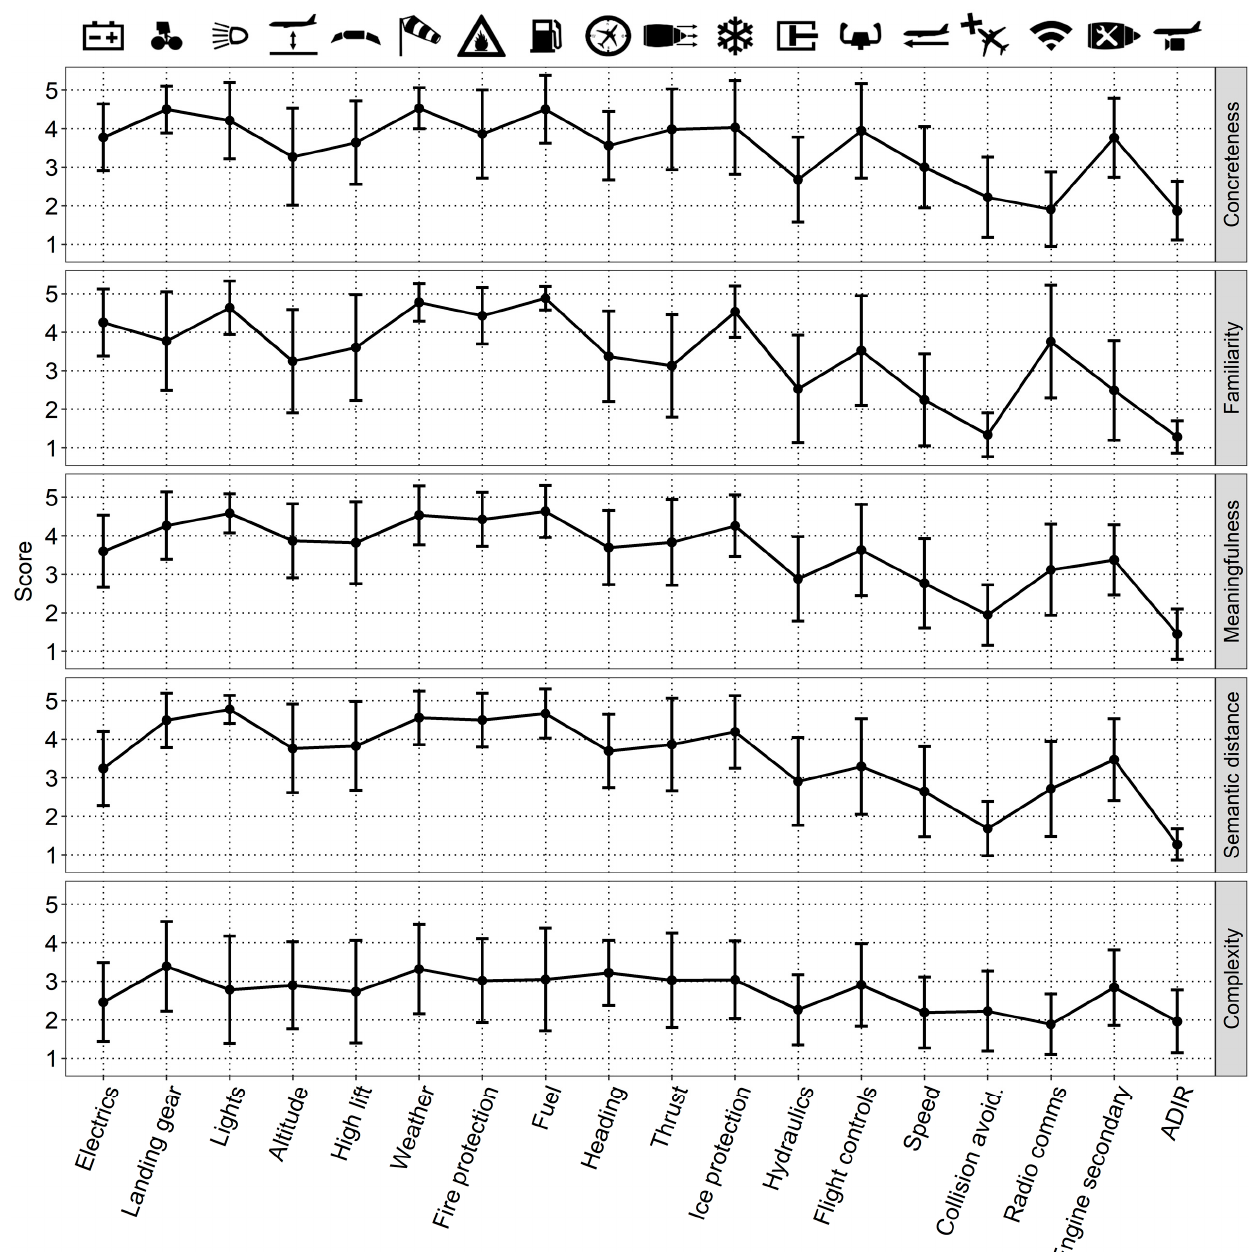
Figure 7. Means and standard deviations for the obtained ratings of each icon characteristic and icon. The icons are ordered by concept agreement. ADIR = Air Data and Inertial Reference.